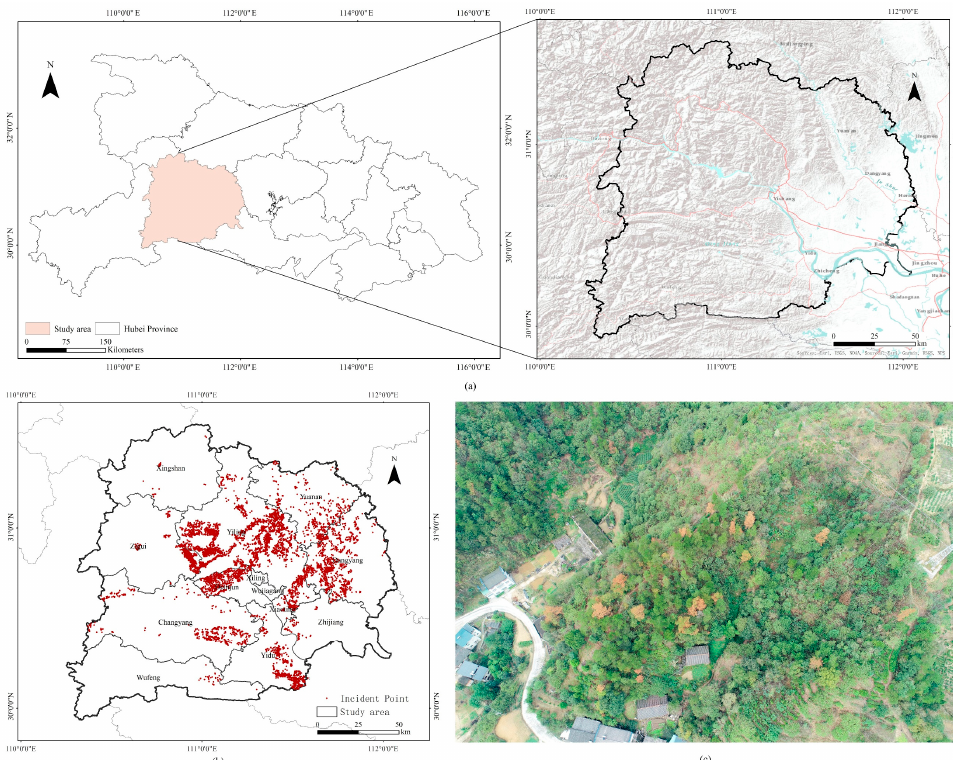
Figure 1. Overview of the study area. ( a ) The study area located in Yichang City, Hubei Province. ( b ) Distribution of occurrence point of PWD. ( c ) Field photo of PWD.